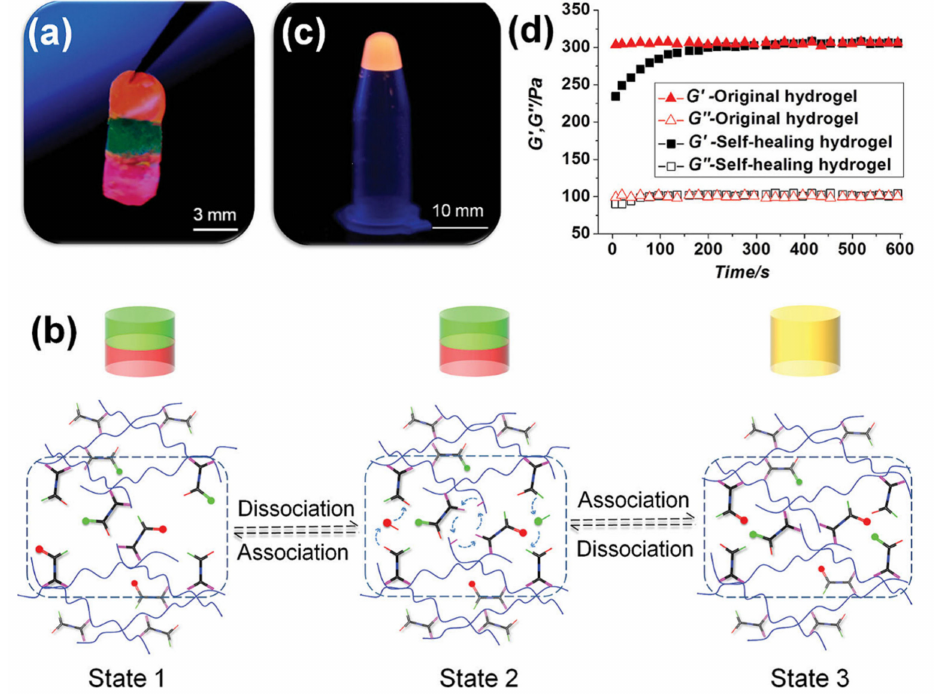
Figure 4. Formation polypeptide − DNA hydrogel with self-healing property, ( a ) the ability of adherence freshly prepared hydrogels (4 wt.%), from bottom to top are 5(6)-ROX modified, 5(6)-FAM modified, and 5(6)-FAM/5(6)-ROX modified polypeptide-DNA hydrogels, respectively, ( b ) mechanism of self-healing through DNA chain exchange, ( c ) three hydrogels treated with dyes, ( d ) mechanical performance of polypeptide − DNA hydrogel. Reused with permission from [71] Copyright © 2021